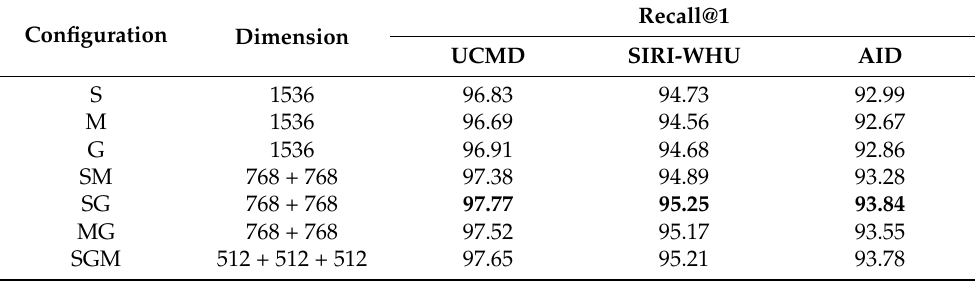
Table 2. Recall@1 (%) of individual descriptor and descriptors ensemble on UCMD, SIRI-WHU, and AID.